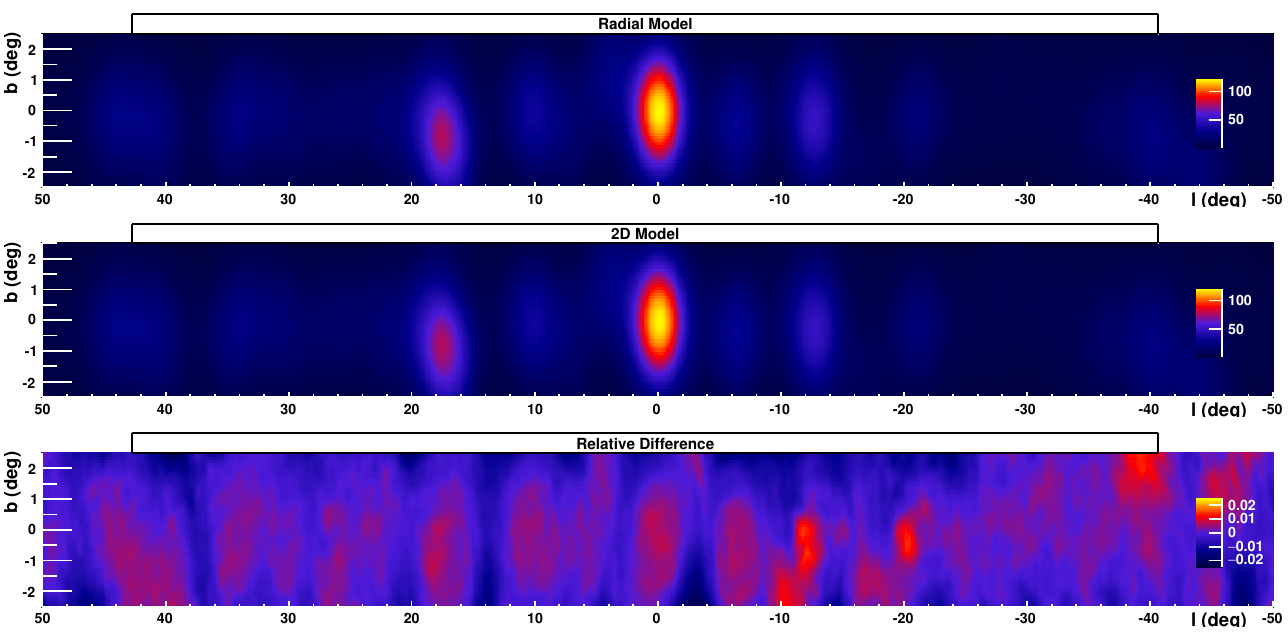
Figure 10. Comparison of radial and 2D acceptances